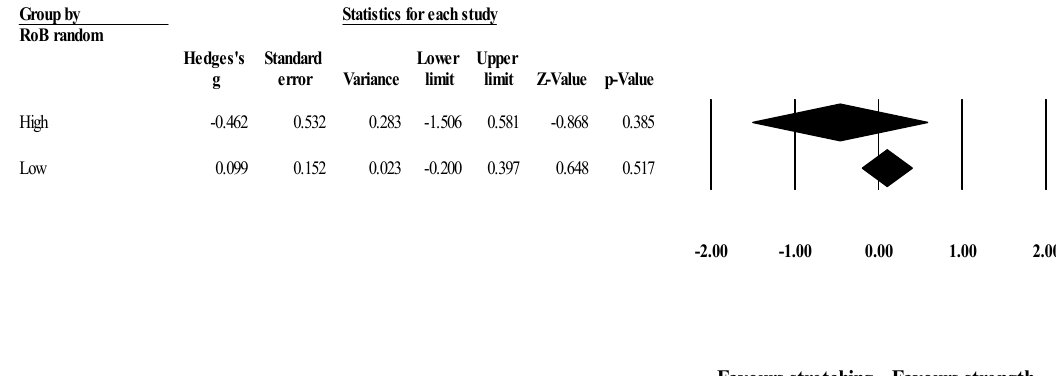
Figure 7. Forest plot of changes in hip flexion ROM after participating in stretching ‐ based compared to strength ‐ based training interventions with high versus low RoB in randomization. Values shown are effect sizes (Hedges’s g) with 95% confidence intervals (CI).